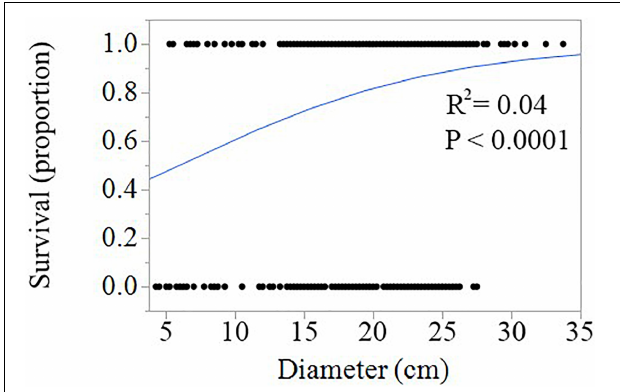
FIGURE 3 | The estimated effect of initial diameter (37 years old) on longleaf pine survival averaged across all seasonal biennial burn treatments and the unburned